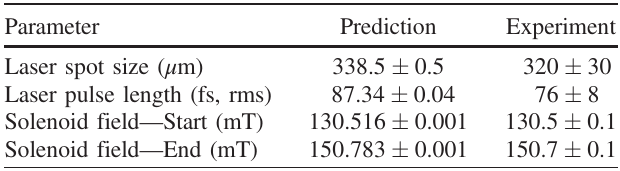
TABLE V. Prediction results for fixed machine